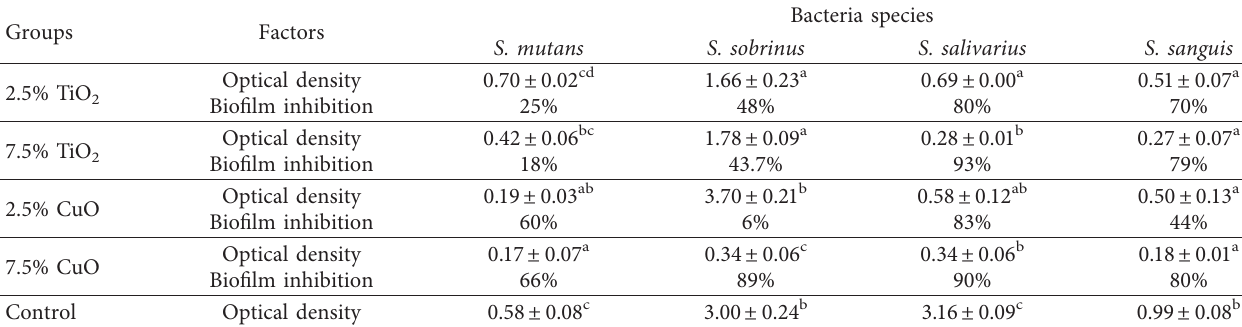
Table 1: Means ± standard deviations, biofilm inhibition (%), and multiple comparisons of optical density of the study groups for bacteria species.